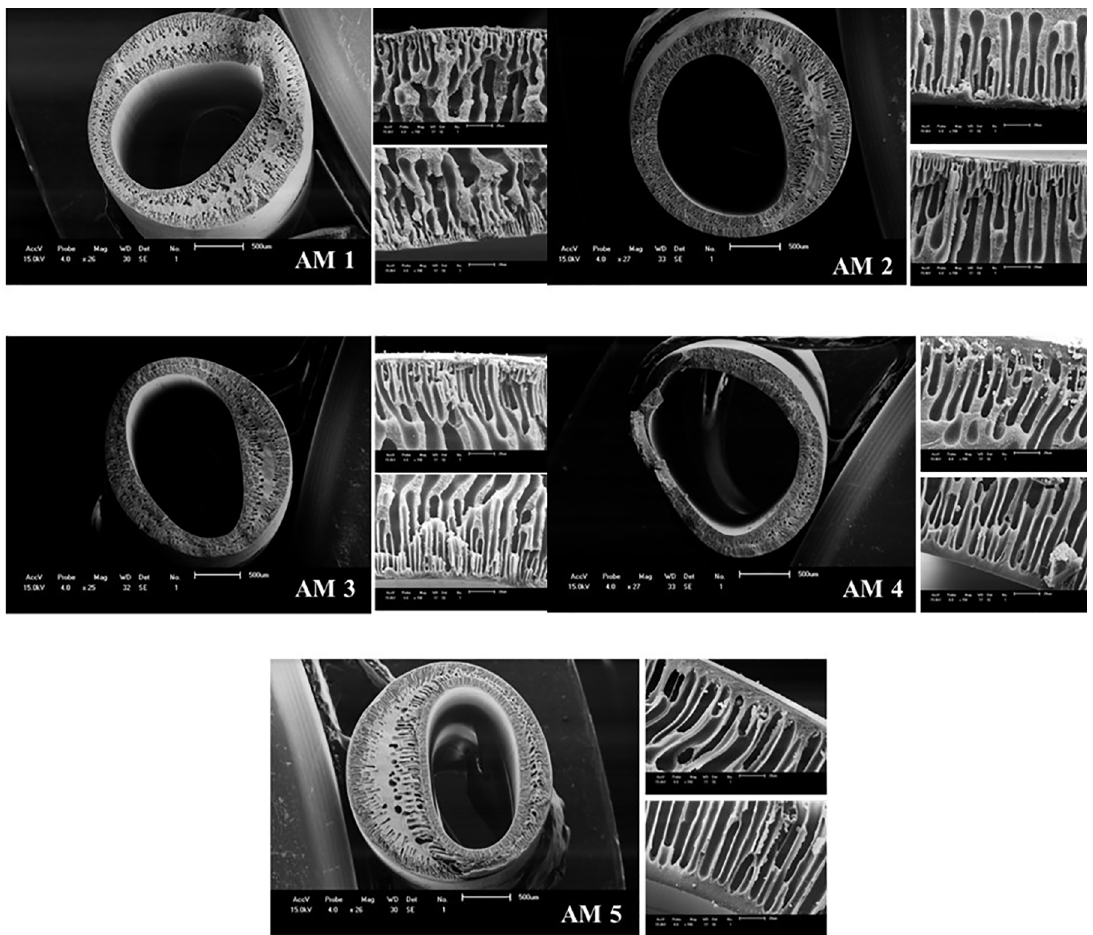
Figure 3. SEM images of PES hollow fiber membranes with PVP concentrations of 1 wt%, 3 wt%, 5 wt%, 7 wt% and 9